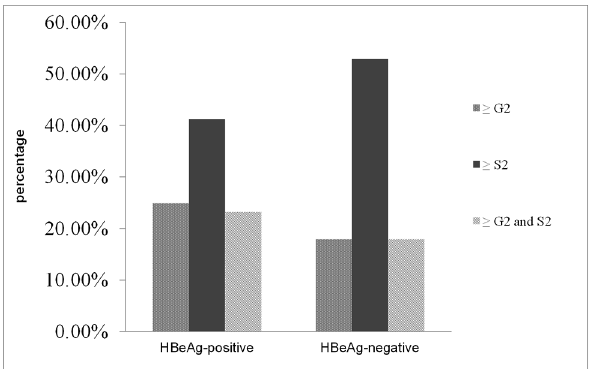
Fig 2. Incidence of necroinflammation (cid:3) 2, or fibrosis (cid:3) 2 or a combination of both (cid:3) G2 and S2. Significant levels of necroinflammation ( (cid:3) G2), fibrosis ( (cid:3) S2), and necroinflammation ( (cid:3) G2) and fibrosis ( (cid:3) S2) occurred in 24.9%, 41.2%, and 23.2%, respectively, in HBeAg-positive patients. Significant levels of necroinflammation ( (cid:3) G2), fibrosis ( (cid:3) S2), and necroinflammation ( (cid:3) G2) and fibrosis ( (cid:3) S2) were seen in 17.9%, 52.9%, and 17.9%, respectively, of the HBeAg-negative patients.